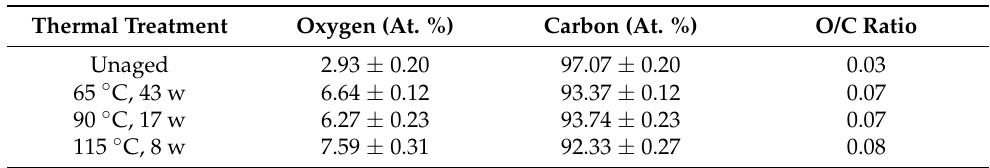
Table 3. Changes in the oxygen to carbon ratio with thermal aging of UHMMPE fibers, specific to the kink-banded areas, based on SEM-EDS study and the atomic percentage data of each element. Data presented are mean ± S.E.M. ( n ≥